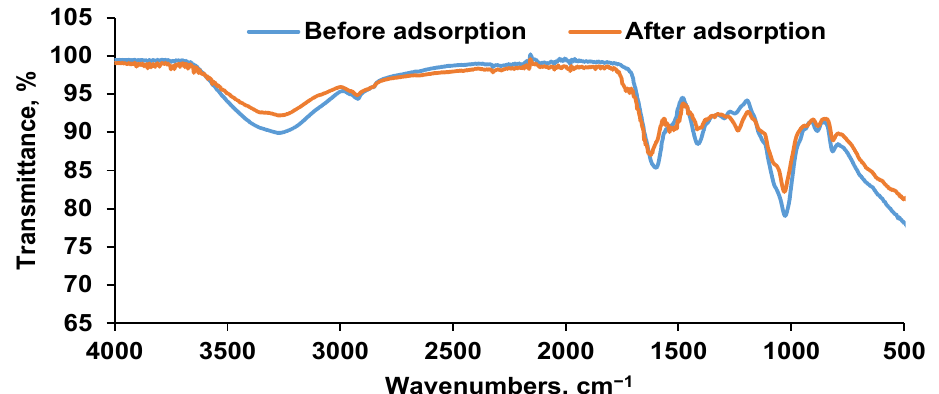
Figure 4. FTIR spectra of the synthesized biosorbent before adsorption and after adsorption of Ethacridine lactate from aqueous solution.